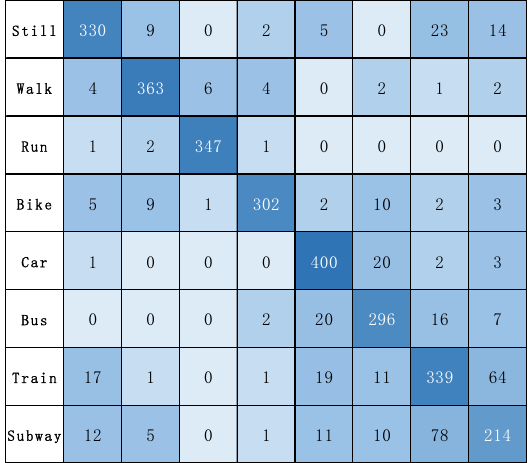
Table 7. Performance comparison between the algorithms of the best teams and the T2Trans algorithm on the HTC dataset for the third SHL recognition challenge.